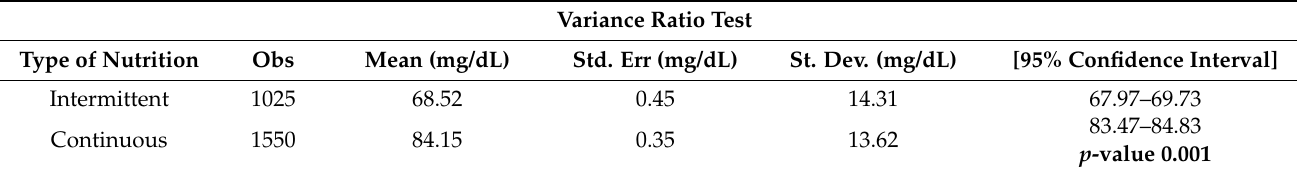
Table 9. Variance ratio test of the observations in SGA babies, based on type of